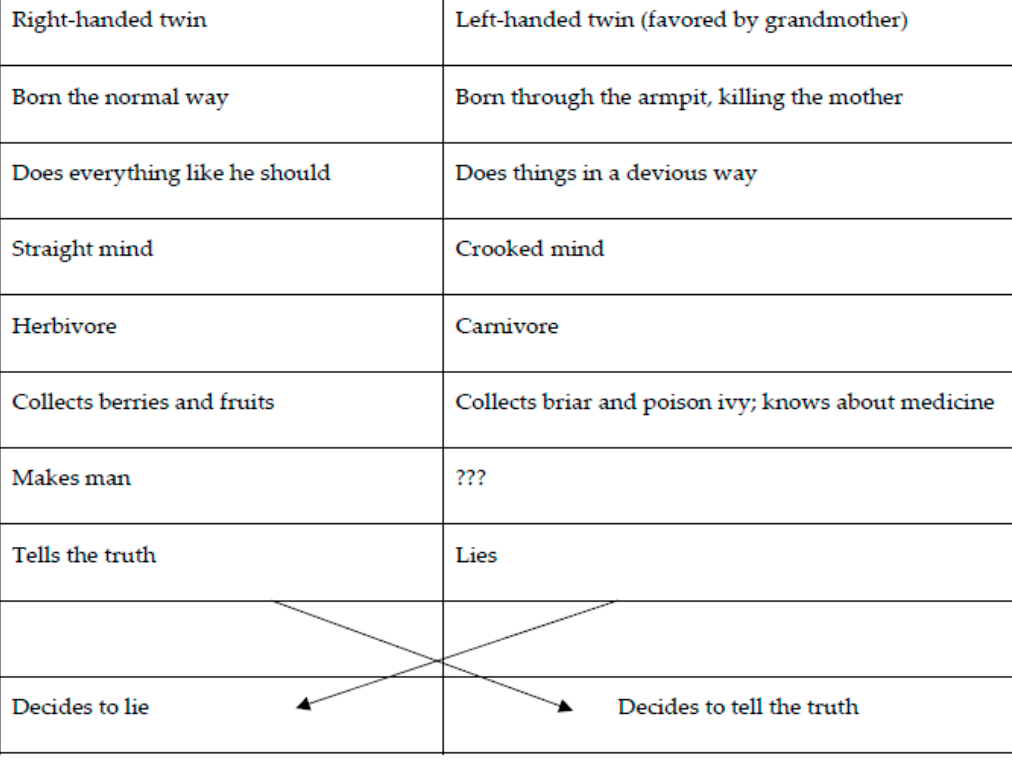
Figure 3. Structure of the Iroquois Origin Myth .